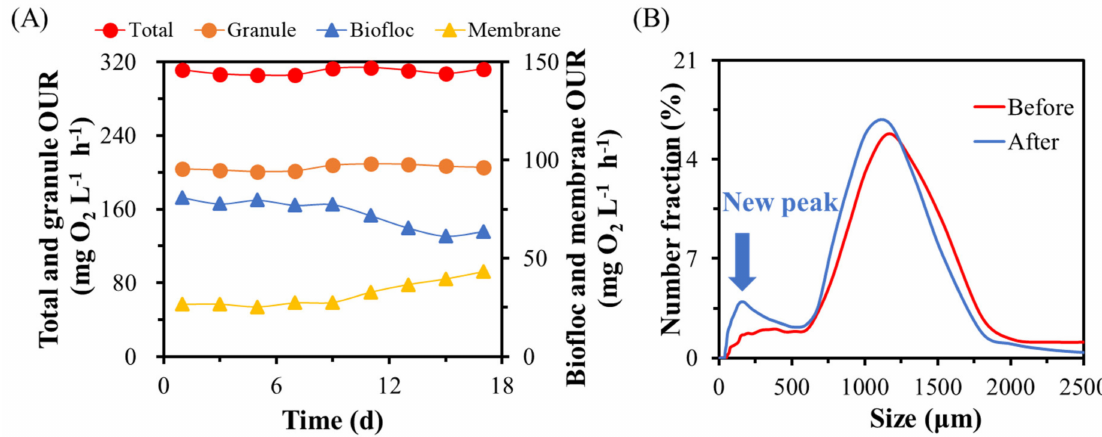
Figure 8. OUR distribution between total, granules, bioflocs, and membrane within one backwash cycle ( A ) and particle size distribution before and after backwash of the membrane ( B